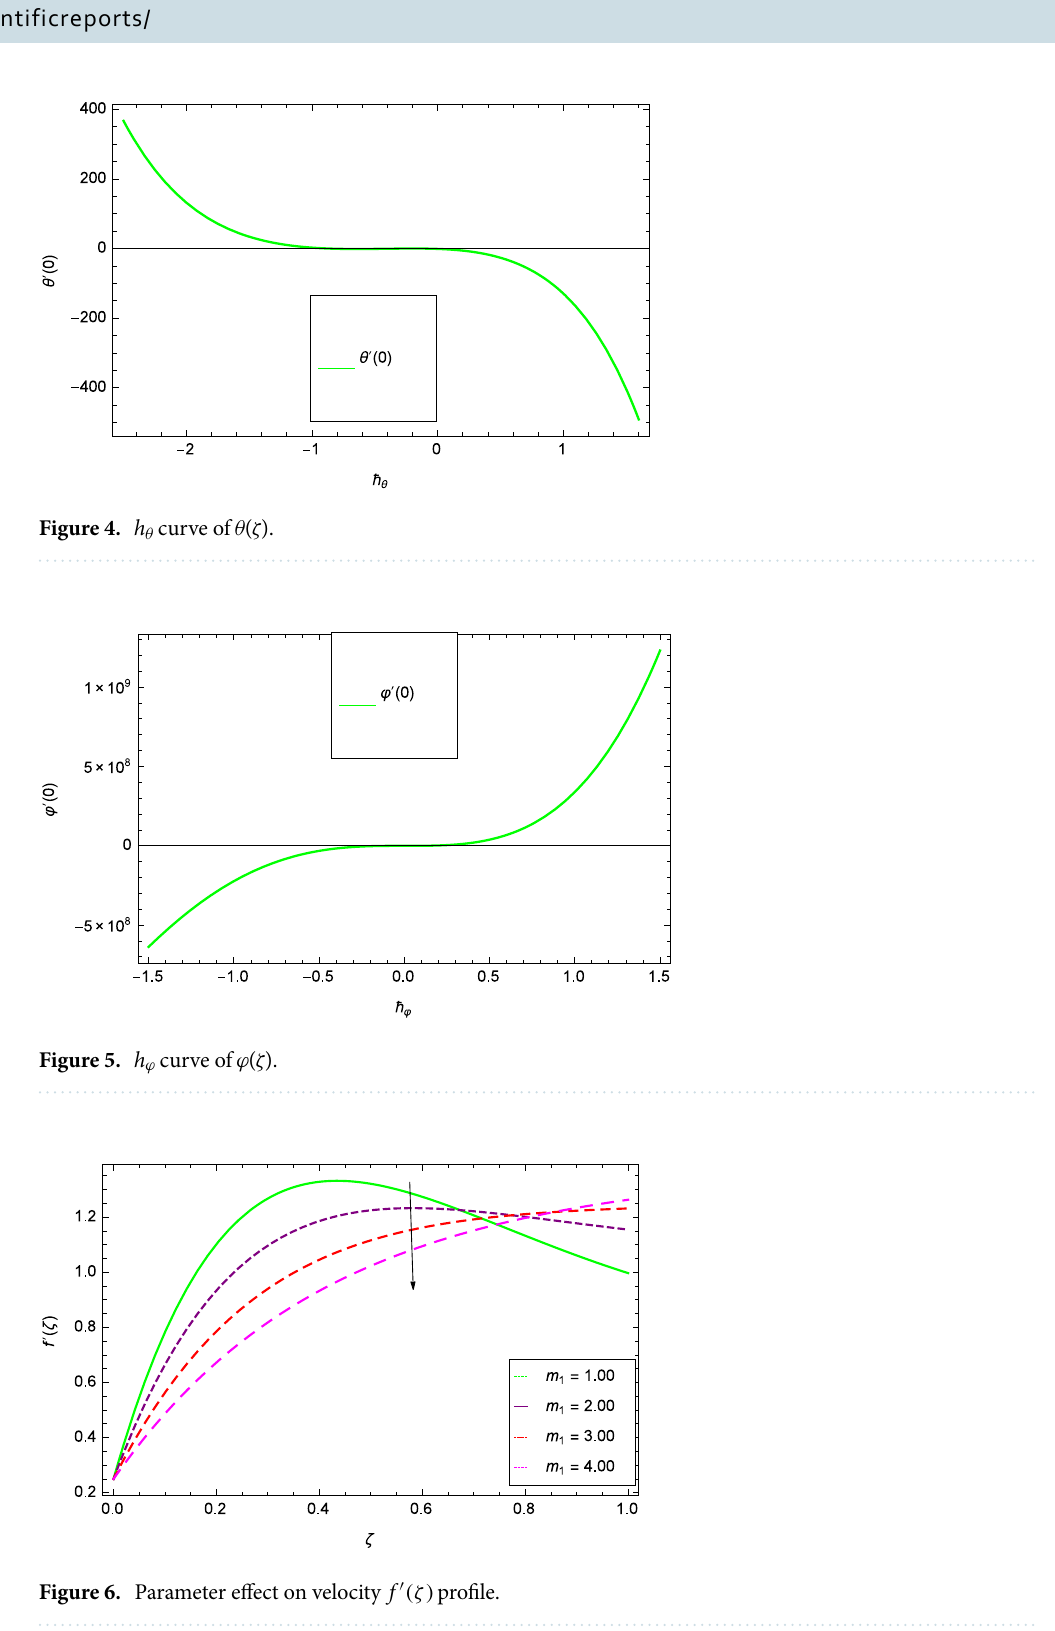
Fig. 9. Through convection, the nanoparticles are excited, consequently, the flow is enhanced. It should be noted that for Gr = 0, the present system corresponds to the pure diffusive boundary layer which has a complete absence